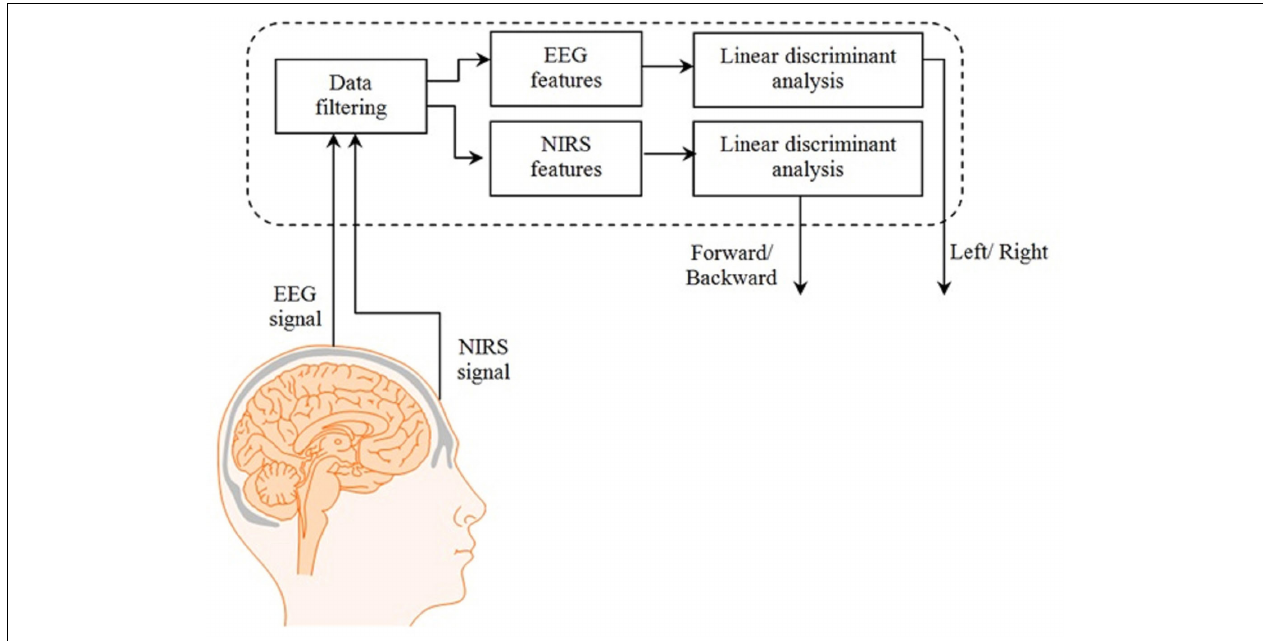
FIGURE 3 | System block diagram. The complete process from signal acquisition to control commands